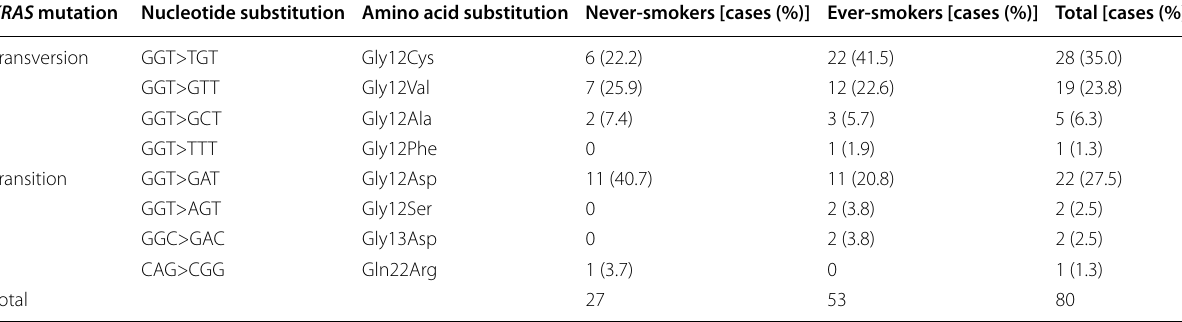
Table 2 Type and frequency of KRAS mutations according to smoking status in 80 patients with NSCLC